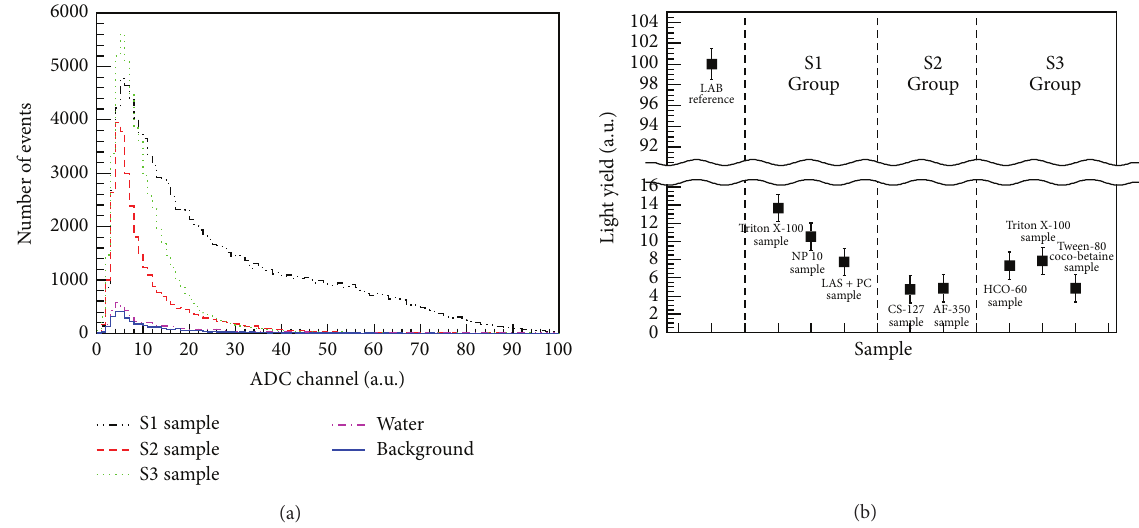
Figure5:(a)Scintillationresponsefromeachsample.(b)Lightyield(LY)ofliquidscintillatorsusingwater.Resultsofsomeliquidscintillators in each group (S1, S2, and S3) with different surfactants are shown. The liquid scintillators using water are excited by using 137 Cs source. A LAB-based LS is used for a reference. We take a LAB-based LS as 100% for comparison with other